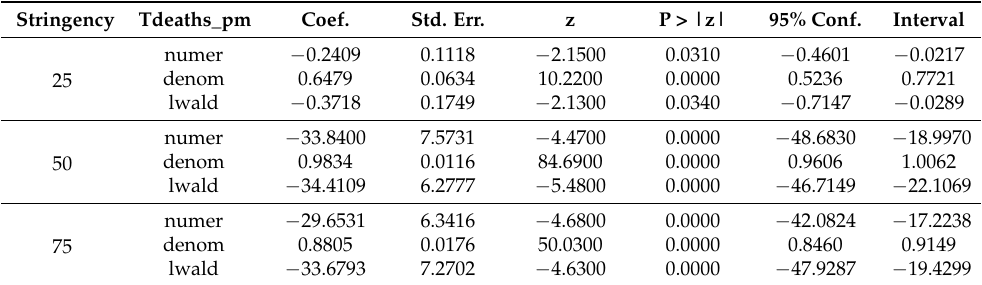
Table 5. Fuzzy regression discontinuity of stringency and tdeaths_pm.